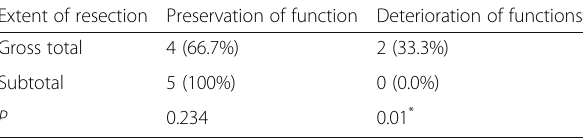
Table 1 Relation between the extent of resection and the sulcal pattern Sulcus type